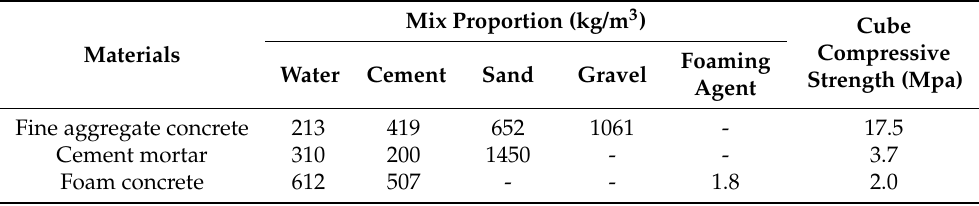
( b ) Figure 5. Schematic and test photos of loading devices: ( a ) schematic figure; ( b ) test photos. The measurements included the specimen’s lateral displacement, the loading point’s force and displacement, and the strain distribution in the C-shaped steel and fine aggre- gate concrete. The arrangement of the linear variable displacement transducer (LVDT) and the strain gauge of each component are shown in Figure 6. The actuator and LVDT automatically collect the loading point’s force and displacement. The static strain collector measures each component’s strain distribution in the core area of the node.